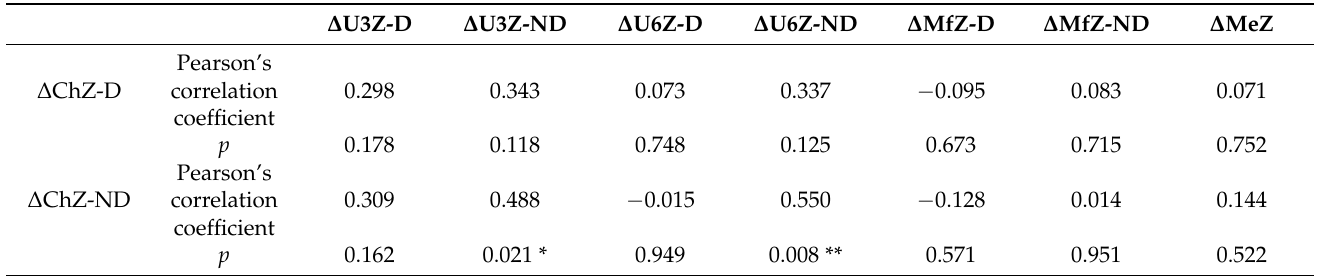
Table 7. Correlation between the vertical changes in the cheilions ( ∆ ChZ-D/ND) and the changes in other variables in the vertical